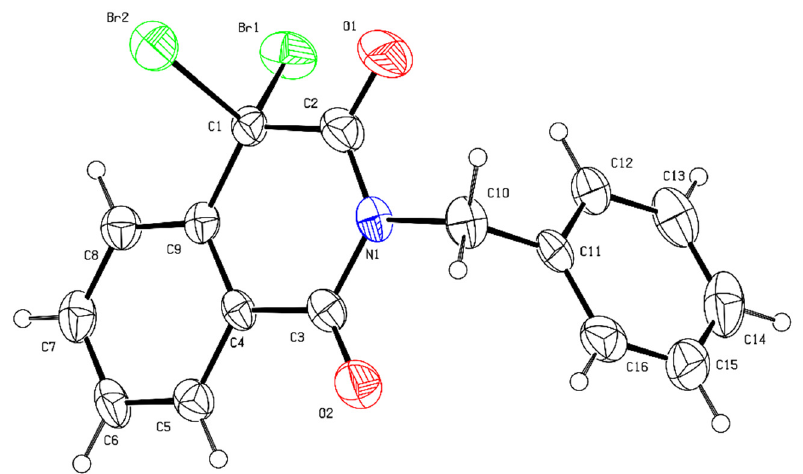
Figure 3. X-ray crystal structure of 3aa .